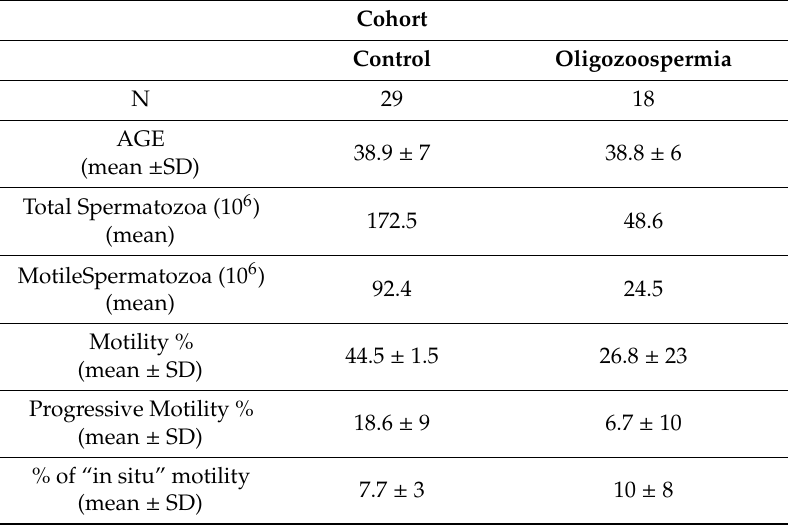
Table 1. Clinical parameters of the patients enrolled in the